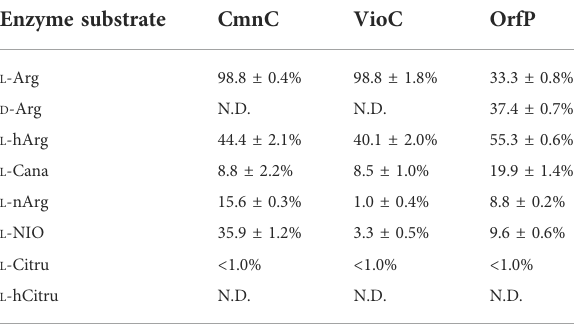
TABLE 1 Relative activities of CmnC, VioC, and OrfP against L -Arg and its analogs. Enzyme